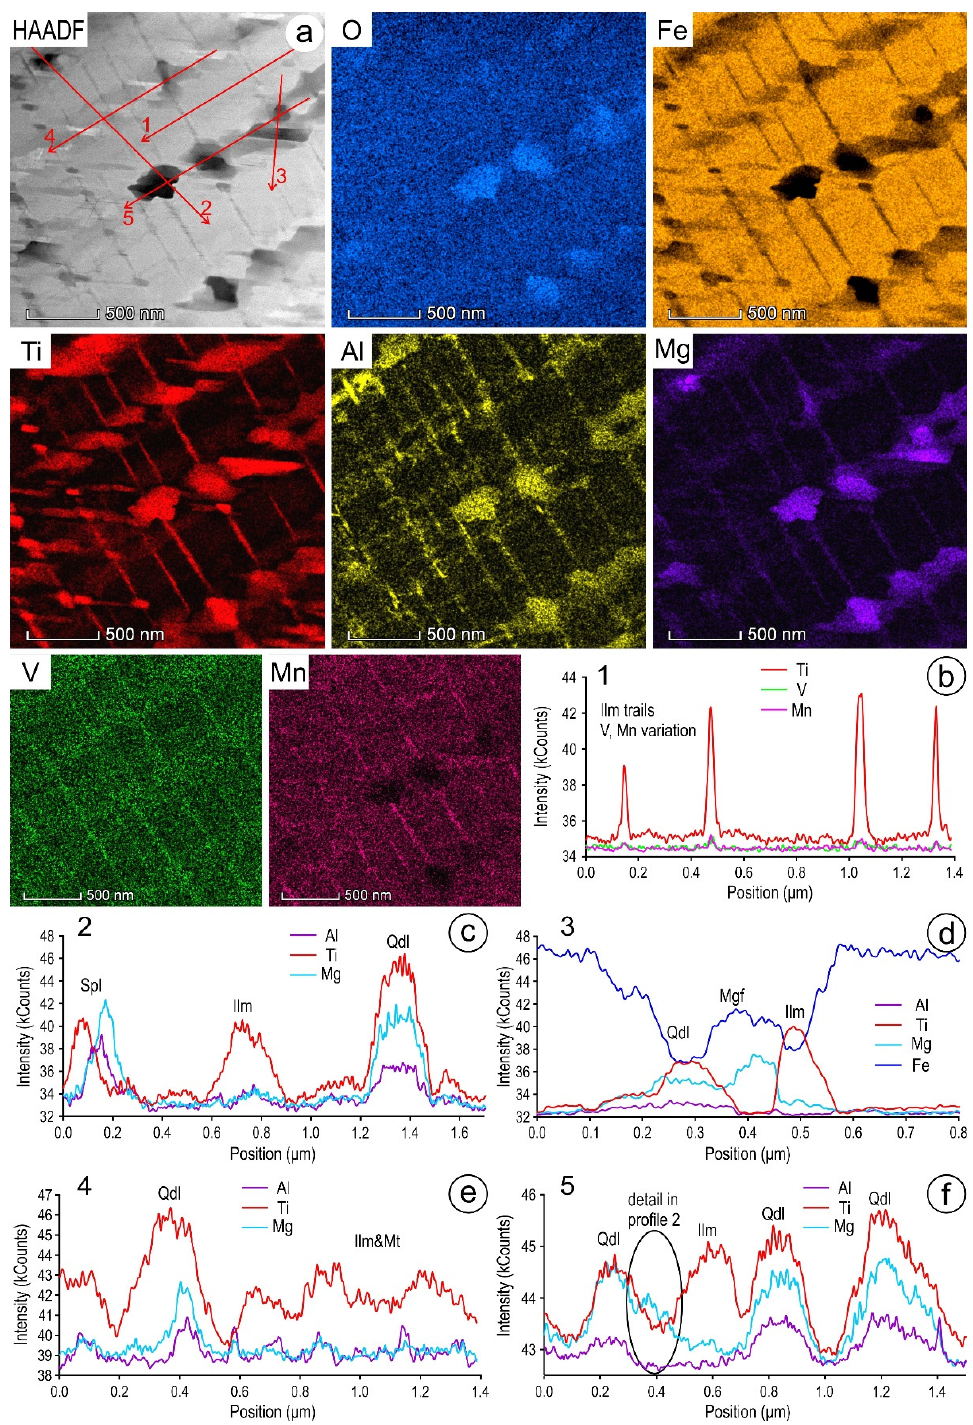
Figure 6. HAADF STEM image and STEM EDS maps ( a ) showing compositional patterns in the inner part of titanomagnetite. Note the presence of spinel minerals with bleb-like morphology highlighted by major elements, whereas linear subsets are only depicted by Ti, Al, and trace elements represented by V and Mn. ( b – f ) EDS line profiles 1–5 as shown in the image showing variation in major and trace elements, as marked. See text for additional explanation. Note: Ilm = ilmenite; Mgf = magnesioferrite; Mt = magnetite; Qdl = qandilite; Spl = spinel.